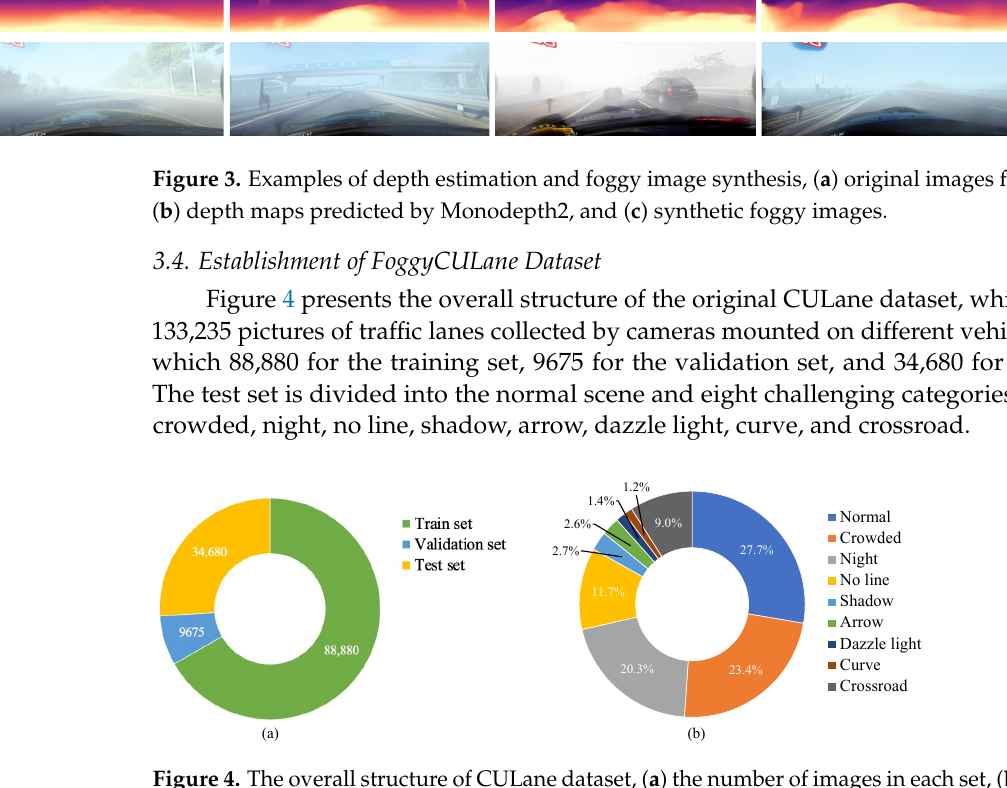
Figure 4. The overall structure of CULane dataset, ( a ) the number of images in each set, ( b ) proportion tion of each scene. of each